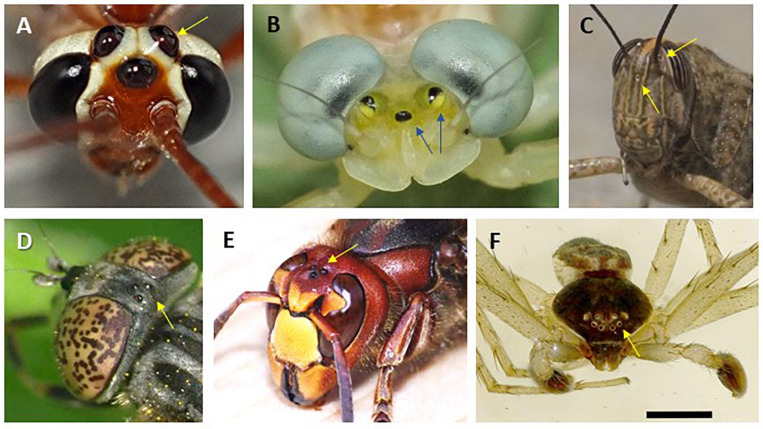
Extra-ocular light perception in various insect species (A-E) and eyes of a spider (F). Arrows point to ocellar structures as found in Netelia sp.
(A), Heptagenia sp.
(B), grasshopper Locusta migratoria
(C), Eristalinus sepulchralis
(D), Vespa cabro
(E), and Philodromus dispar
(F). Photo credits: P. Falatico (A,B,D,E; @ http://aramel.free.fr/), J Falcón (C), D. Vaudoré (F; @https://www.galerie-insecte.org/galerie/ref-183890.htm). No special permissions required.